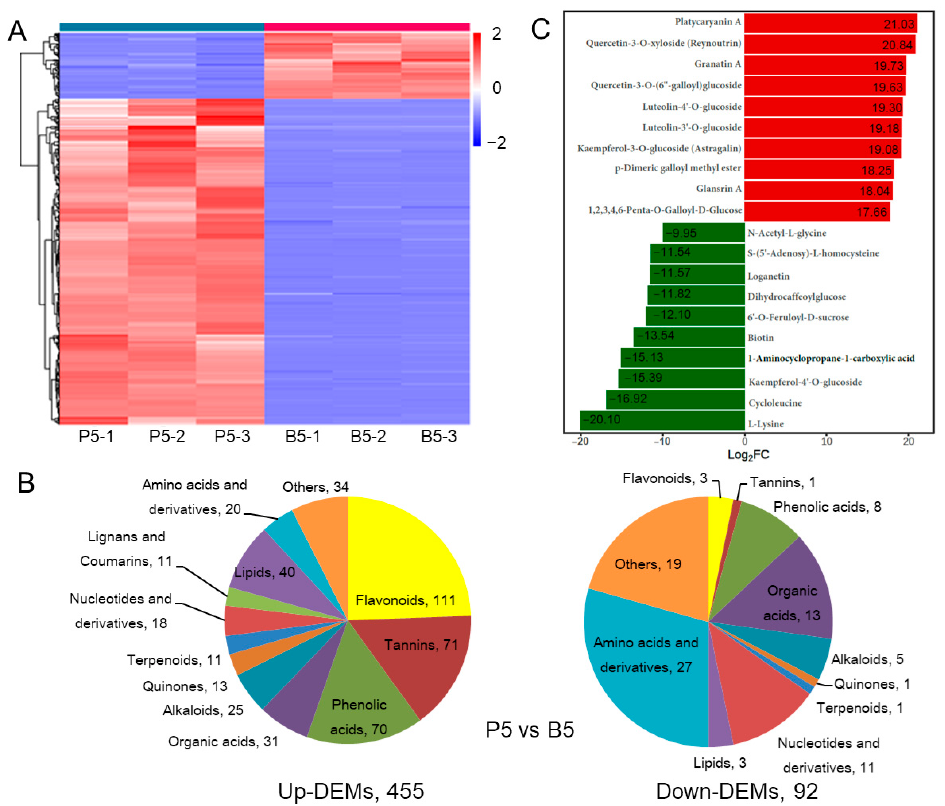
Figure 2. Differentially accumulated metabolites (DAMs) between endopleura and embryo in mature nut. ( A ) The heat map of DAMs in P5 vs. B5. ( B ) The classification of up ‐ and down ‐ DAMs, and the number of each classification. ( C ) Twenty metabolites with the greatest difference in content between endopleura and embryo. Table 1. KEGG enrichment analysis of the DAMs between endopleura and embryo in the mature nut. KEGG